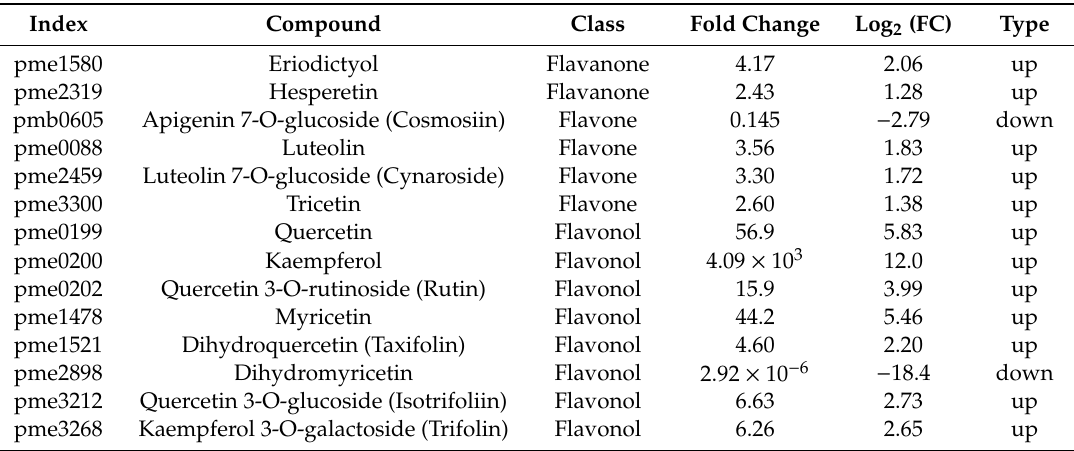
Table 3. DAMs involved in flavonoid biosynthesis during somatic embryo development (GE vs. PEC).